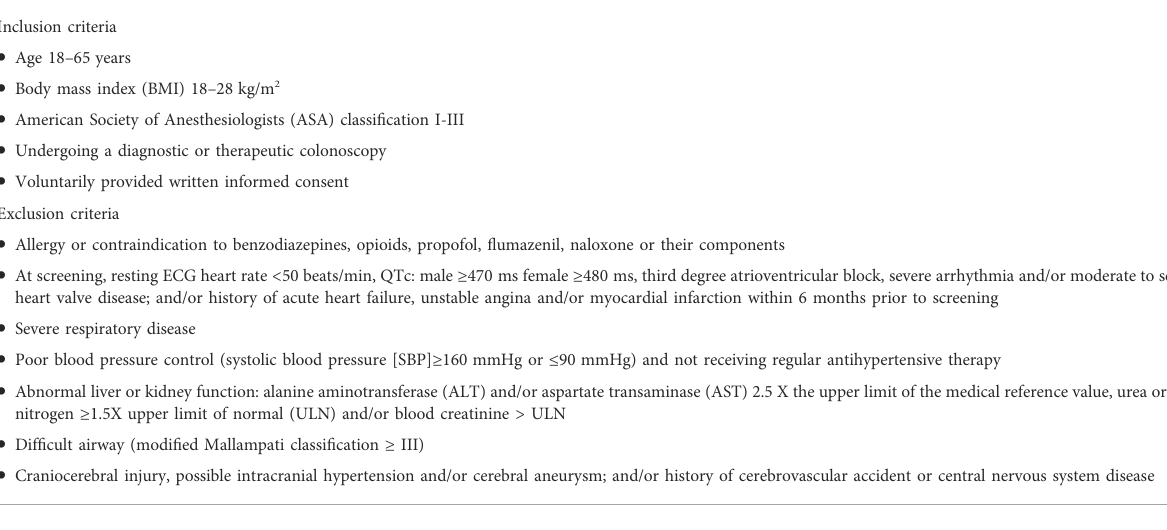
TABLE 1 Inclusion and Exclusion criteria. Inclusion criteria (cid:129) Age 18 – 65